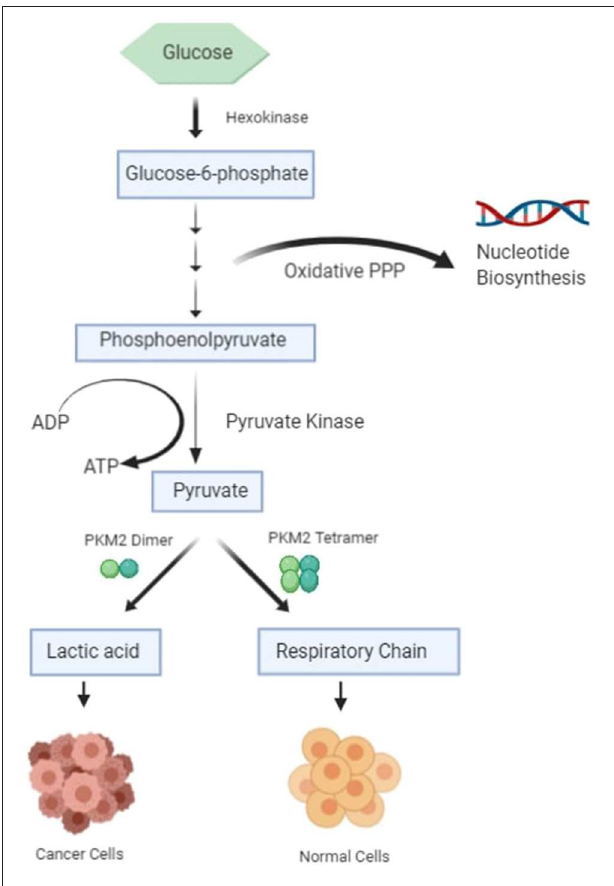
FIGURE 1 | Schematic diagram of glucose metabolism in healthy cells and cancer cells.